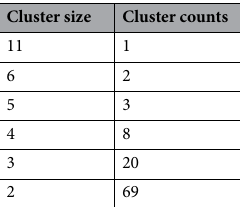
Table 1. Target protein clustering results. There are total of 103 clusters and 268